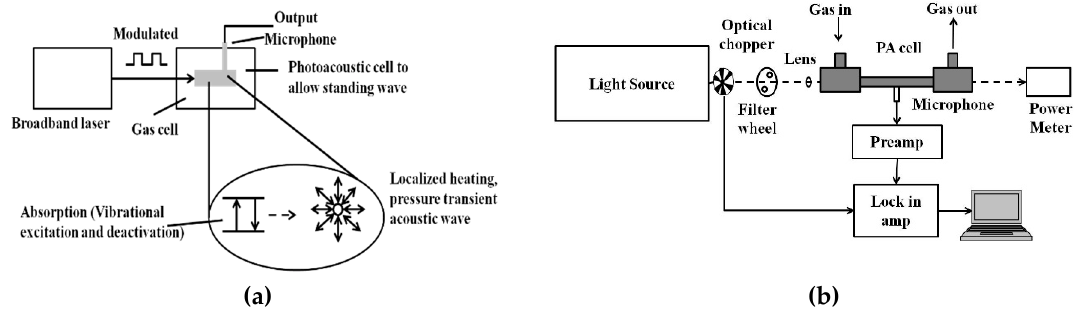
Figure 4. ( a ) General schematic of the photoacoustic (PA) signal generation process; ( b ) general schematic of the PA sensor architecture.